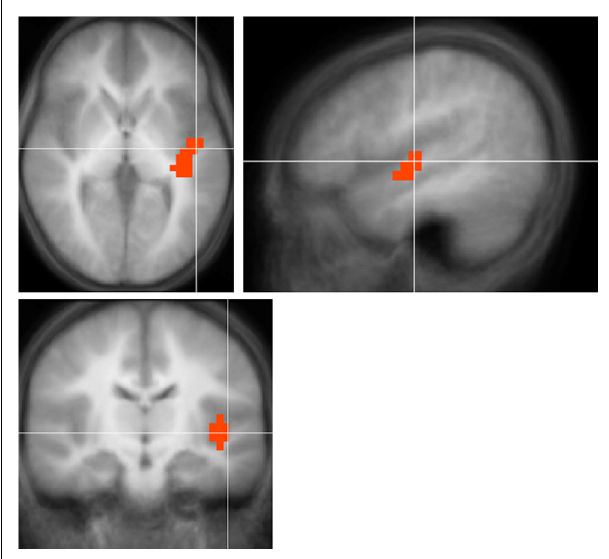
FIGURE 2 | Region with significantly greater functional activation in children with unilateral hearing loss for the fMRI audio–visual paradigm of a modified “TokenTest” (described in more detail in the text) compared to normal-hearing controls. Images in radiologic orientation. Slice locations (Talairach coordinate system): Z = + 2 mm (Axial); X = − 46 mm (Sagittal); Y = − 12 mm (Coronal).